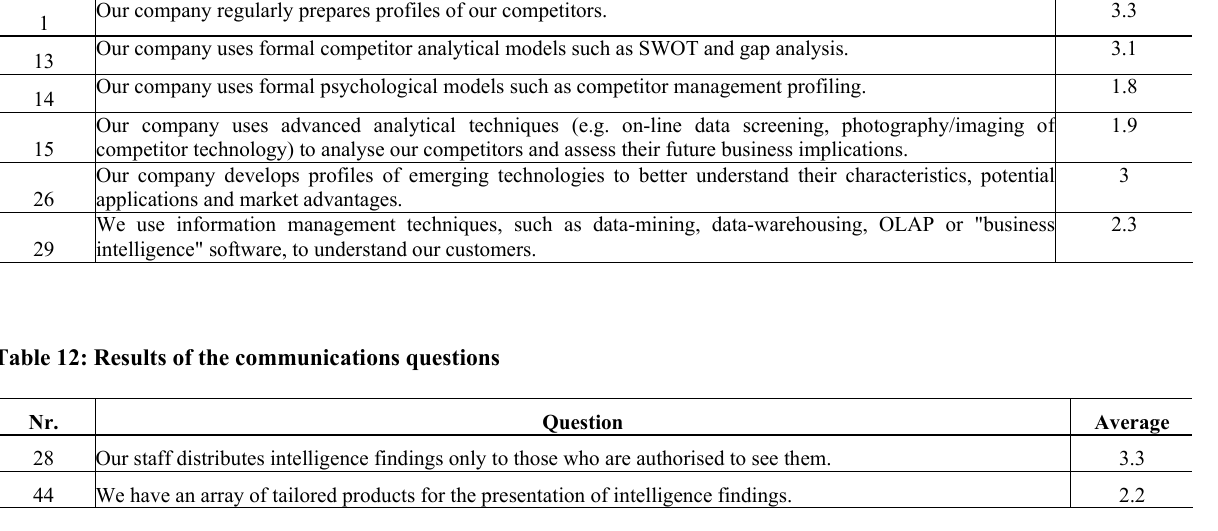
Table 11: Results of analysis questions Nr.